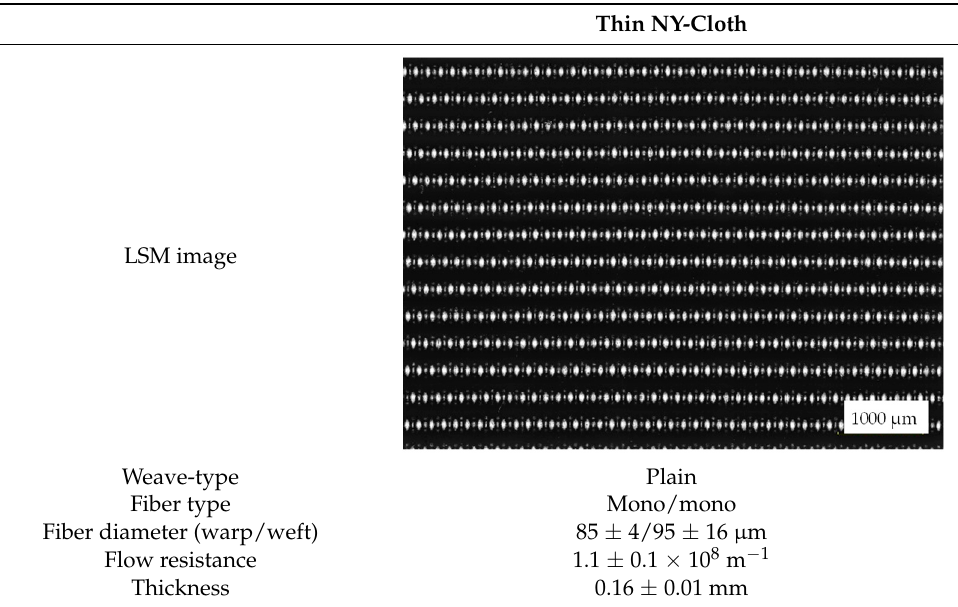
Table 1. Properties of apparatus parameter tests filter cloth.